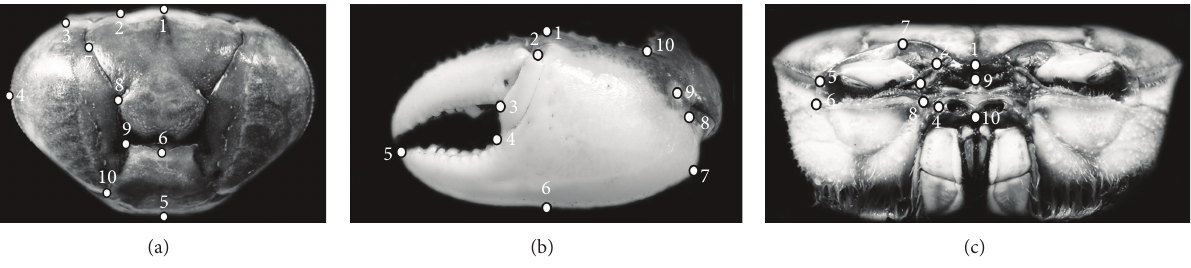
Figure 1: Ucides cordatus (Linnaeus, 1763): localization of landmarks in each anatomic area. (a) Dorsal area of carapace—C; (b) outer face of major cheliped—MC; and (c) anterior region of